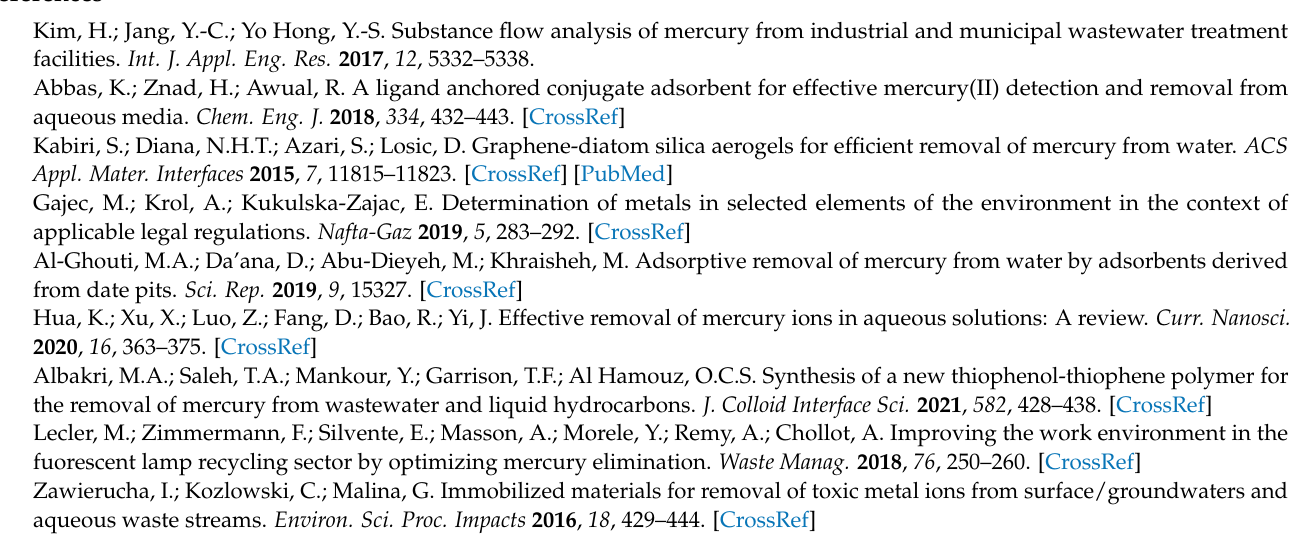
Figure S2: FT-IR spectrum of meso